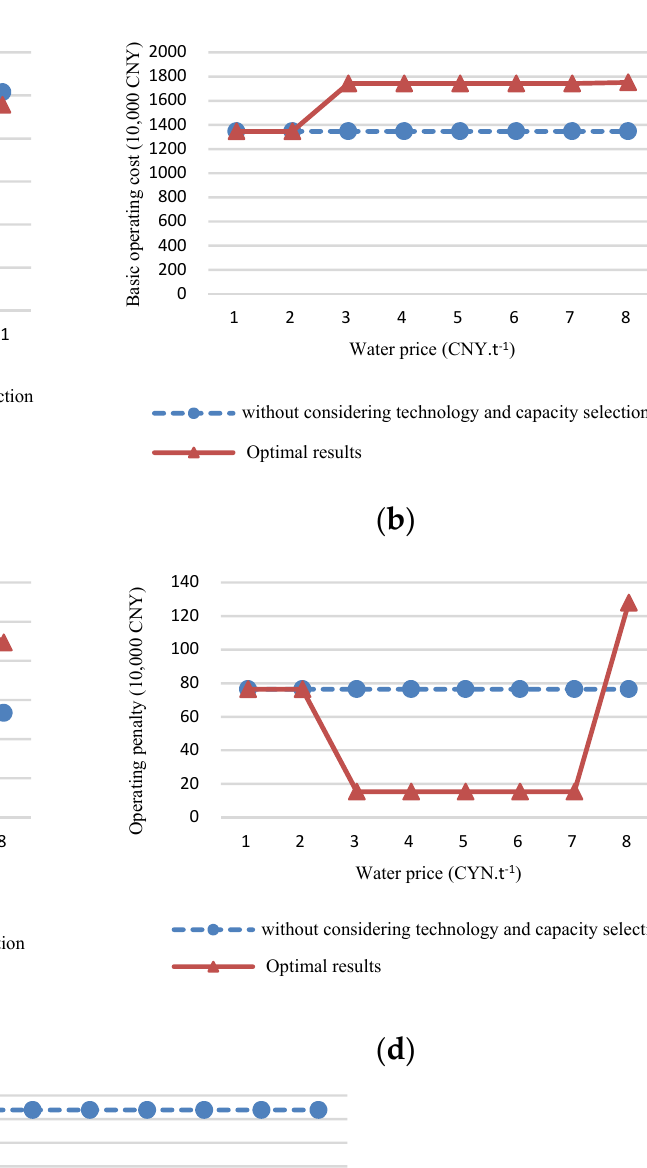
13 of 22 ( c ) Figure 4. Cost comparison of desalination unit cost before and after optimization: ( a ) operating penalty cost; ( b ) investment cost; ( c ) total cost of operating penalty and investment. We also analyzed the influences of changing the municipal water prices on total an- nualized cost, operating cost, investment cost, operating penalty cost, and wastewater treatment cost of desalination unit for a single time period. The comparison of different costs before and after the optimization, with and without considering the technology and